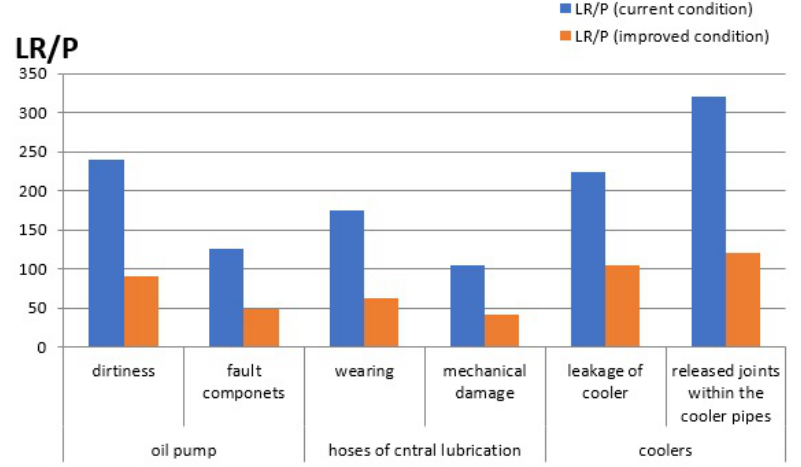
Figure 4: FMEA results for engine lubrication and cooling of harvester John Deere